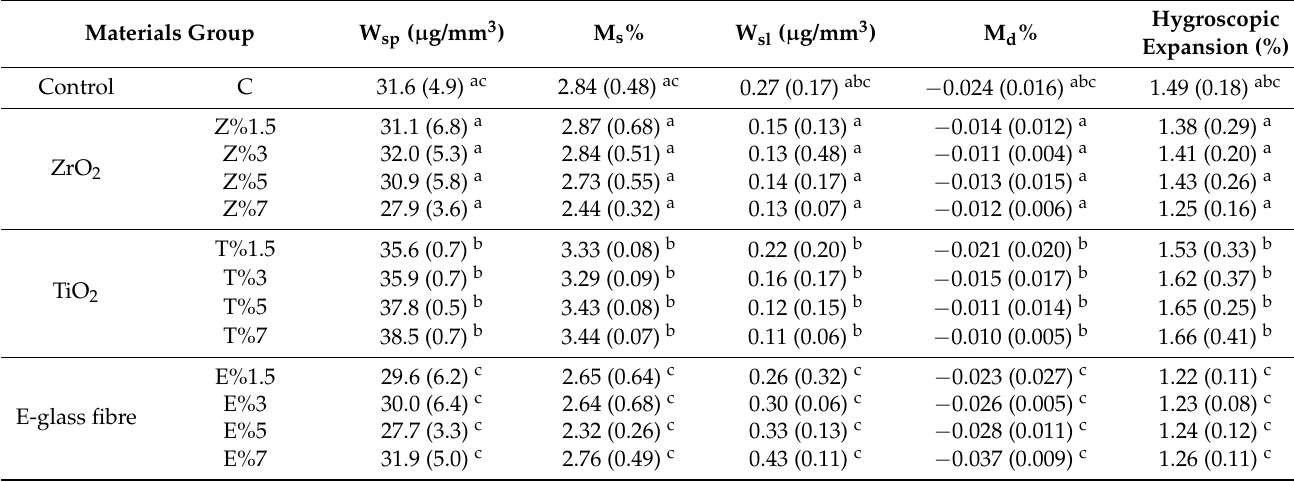
Note: Same superscript letter within column represents non-significant difference between each filler reinforced group and control group ( p >